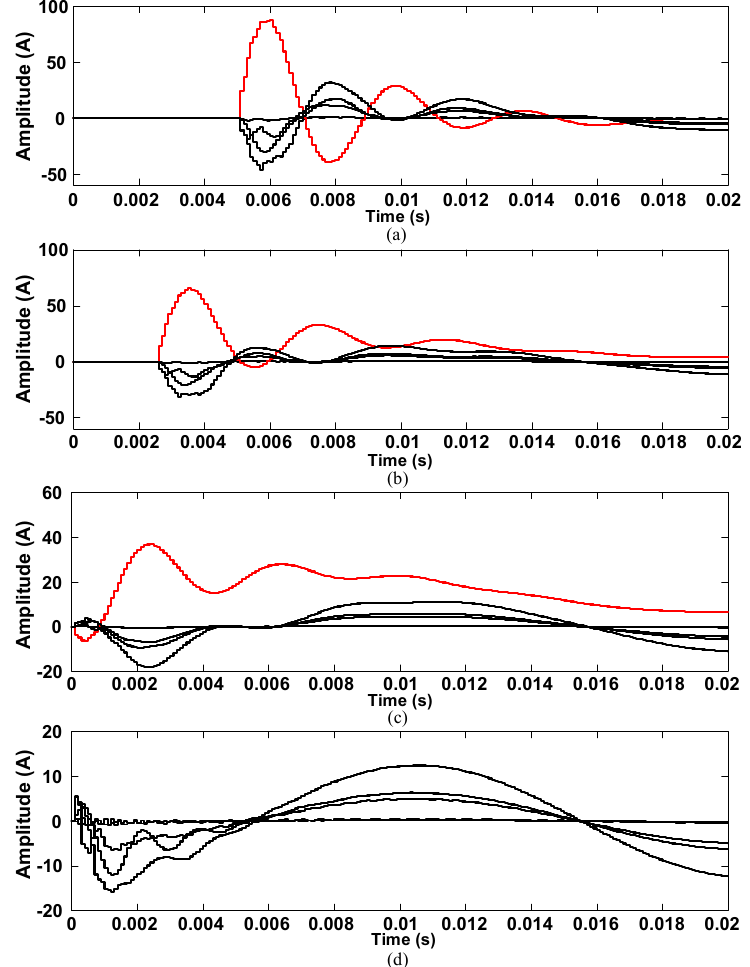
Figure 9. Transient waveforms when R d = 0 Ω : ( a )( b )( c ) Feeder faults; ( d ) bus fault.